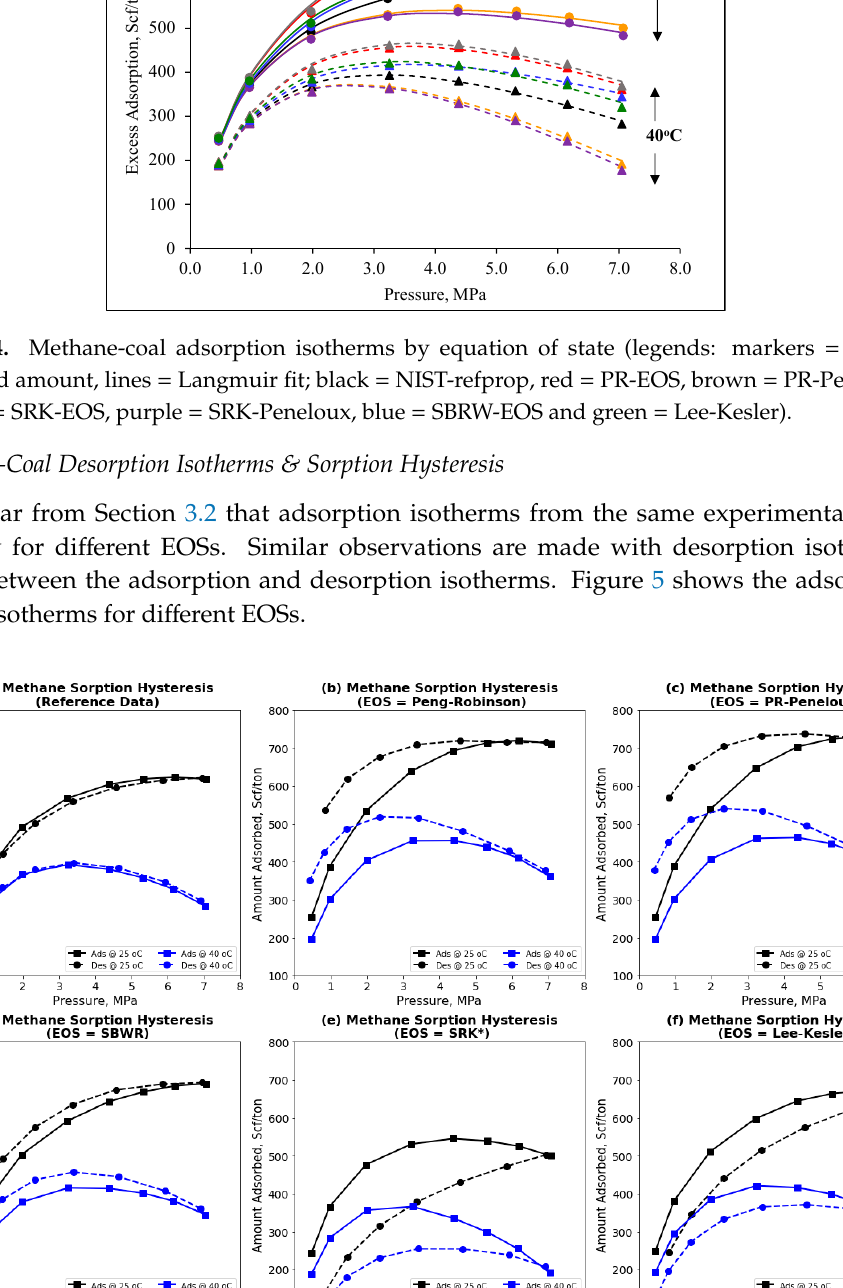
Figure 5. Methane-coal sorption hysteresis by equation of state (* SRK-Peneloux is similar).